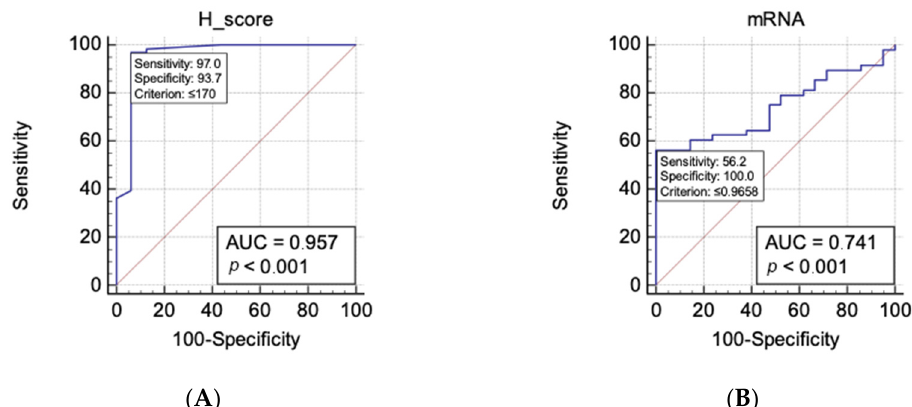
Figure 3. ROC curves for differentiation of OSCC from normal tissue and their accuracy using ( A ) H-score and ( B ) ZNF- 281 mRNA transcript level normalized with ACTB